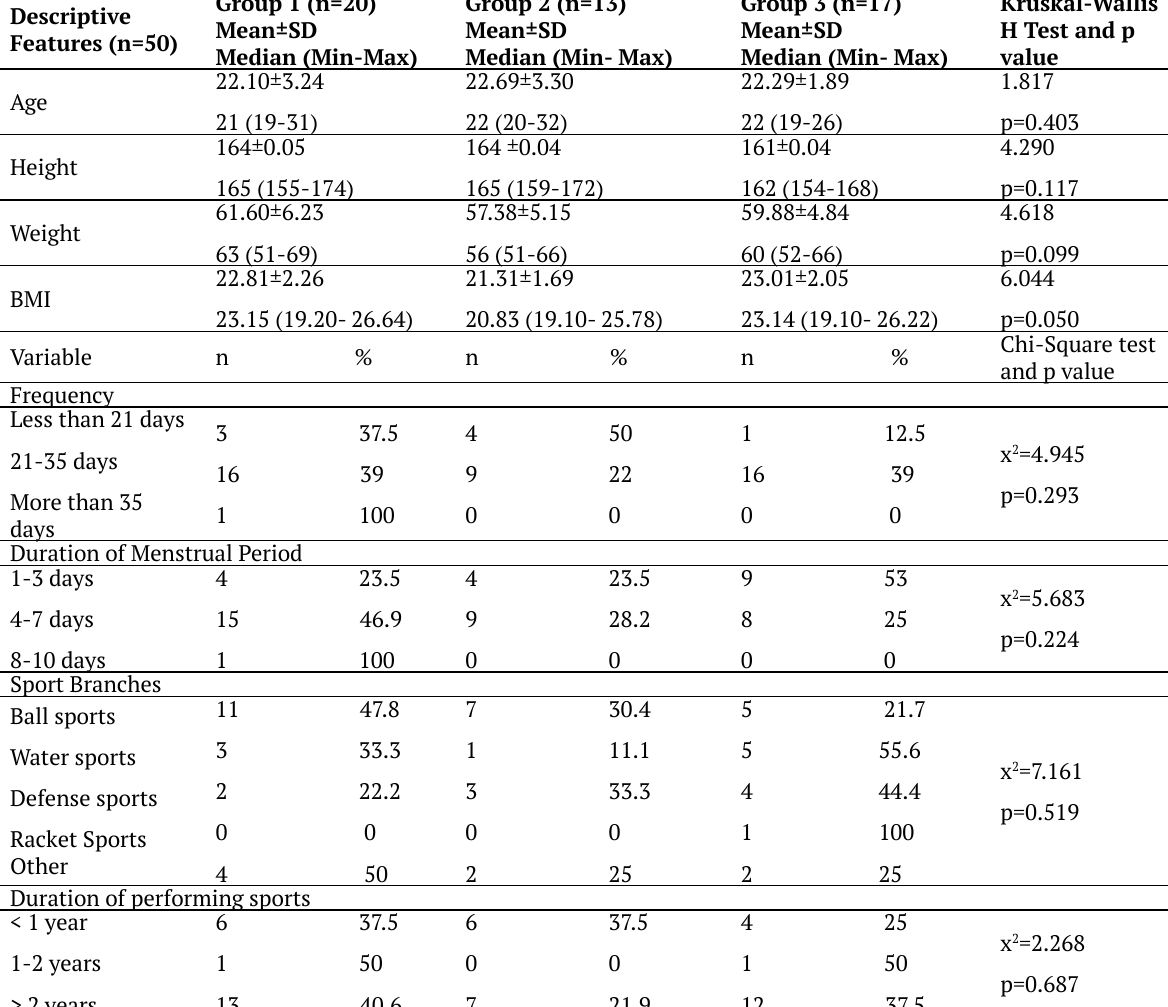
Table 1. Comparison of the groups in terms of demographic and sport-specific